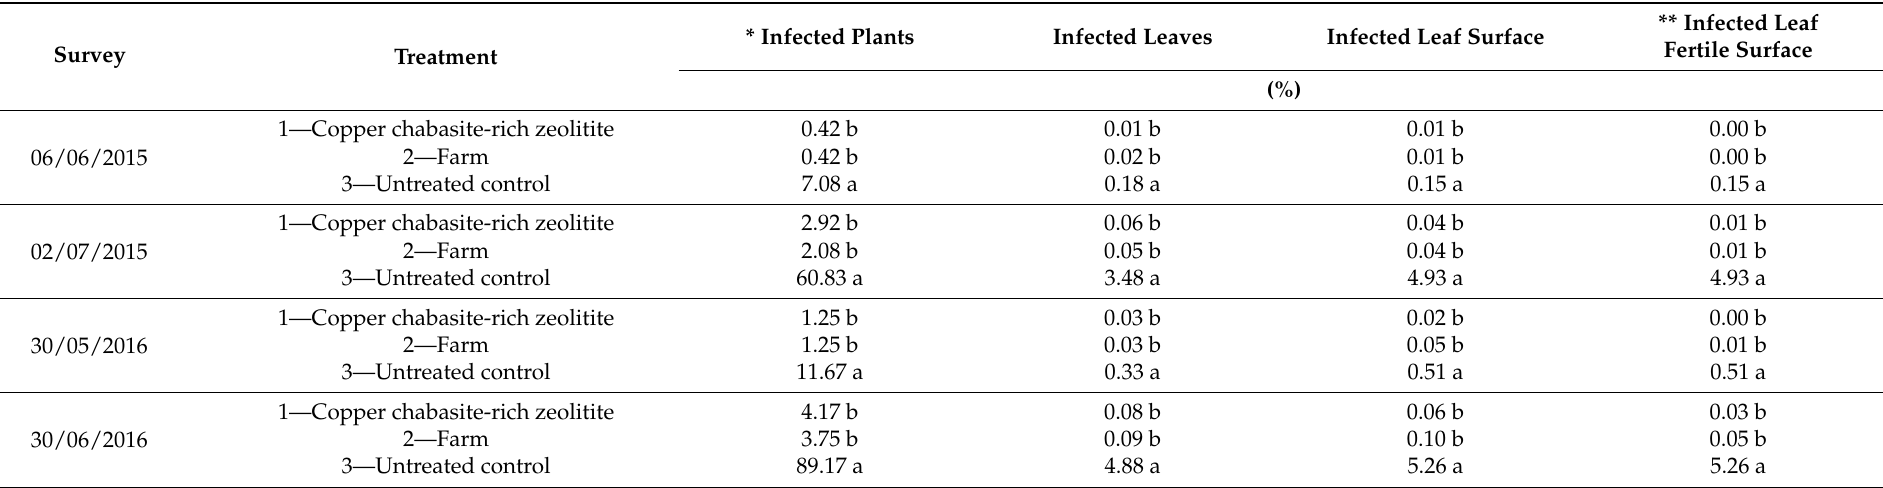
Table 3. Comparison of incidence and severity among control strategies of grapevine downy mildew based on applications of Italian copper chabasite-rich zeolitite or fungicides provided for the farm plan in the Montepulciano cultivar of Ari vineyard: leaf